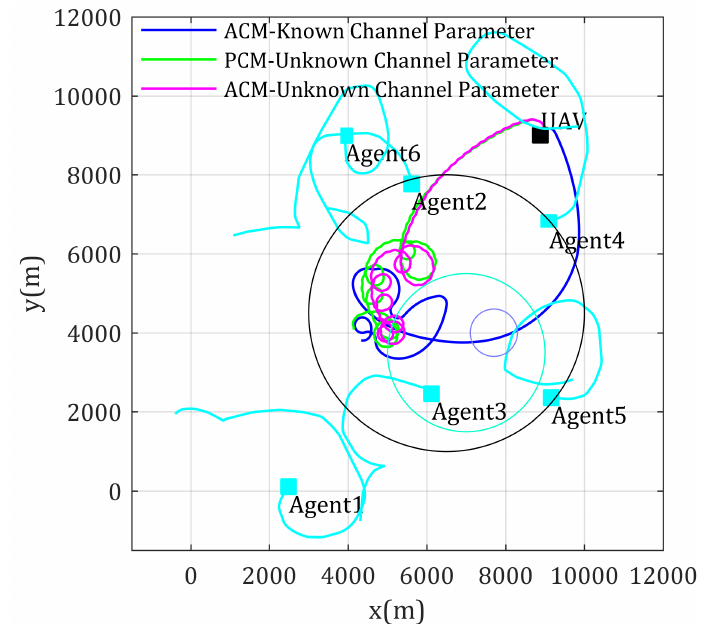
Figure 16. Paths for multi-mobile-agents-inter communication with unknown channel parameters.